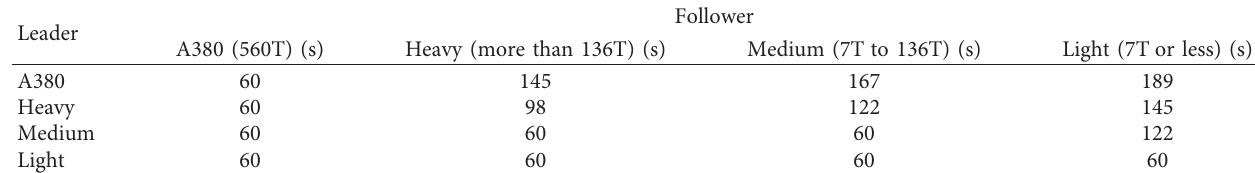
Table 10: Time separation standard [29].